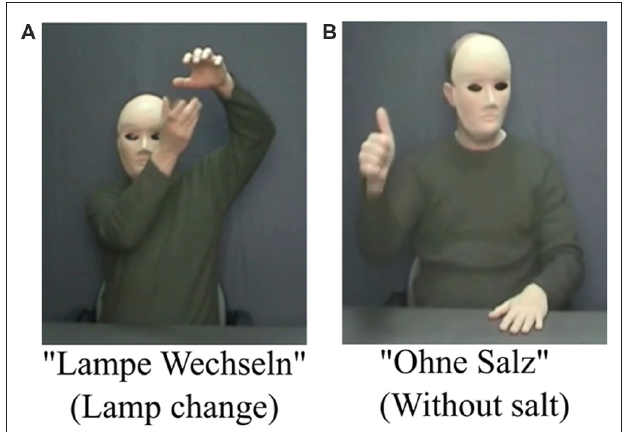
FIGURE 2 | Examples of congruent and incongruent stimuli. (A) A gesture congruent with the word meaning and (B) a gesture incongruent with the word